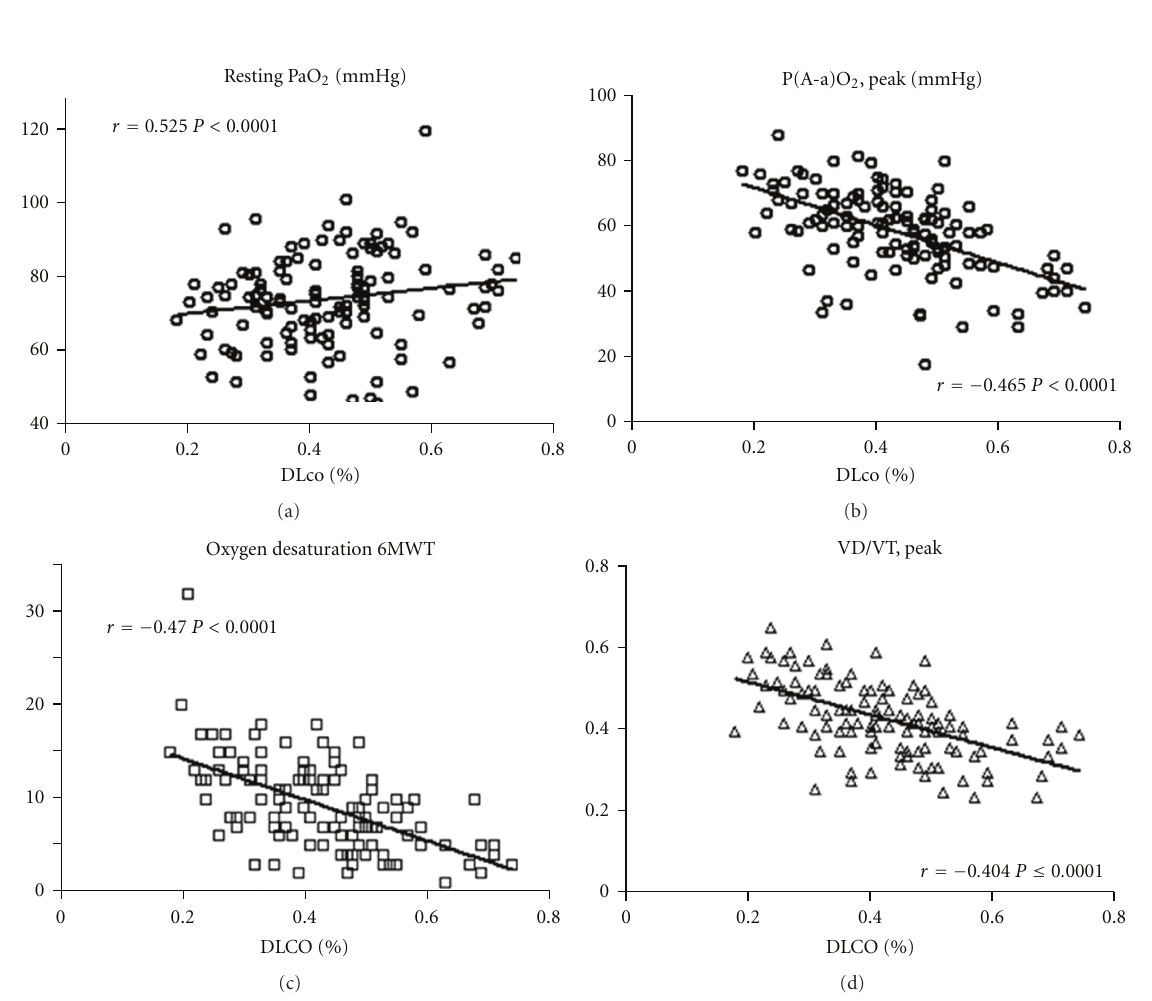
Figure 1: Correlation between DLCO (percent predicted) and resting PaO 2 , P(A-a)O 2 , peak, oxygen desaturation during 6MWT and VD/VT, peak in fibrotic